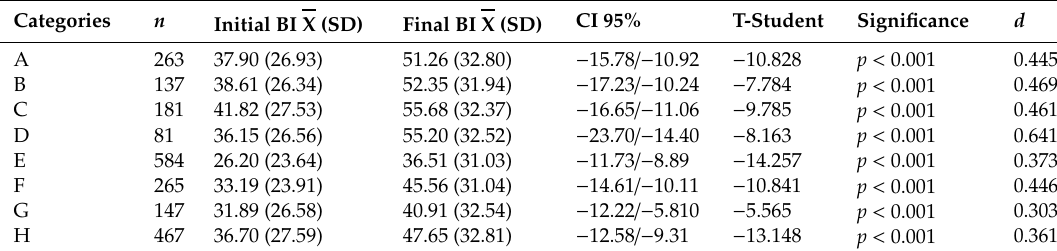
Table 2. Student’s t -test for initial and final Barthel index (BI) per clinical